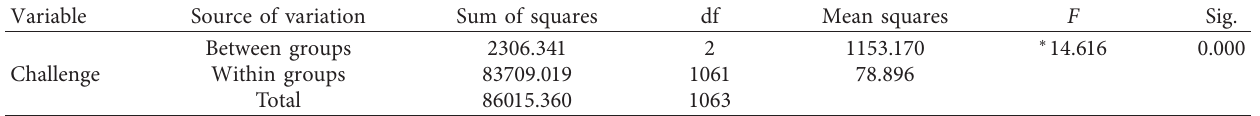
Table 8: Summary of ANOVA for issues related to challenges of cooperative learning across